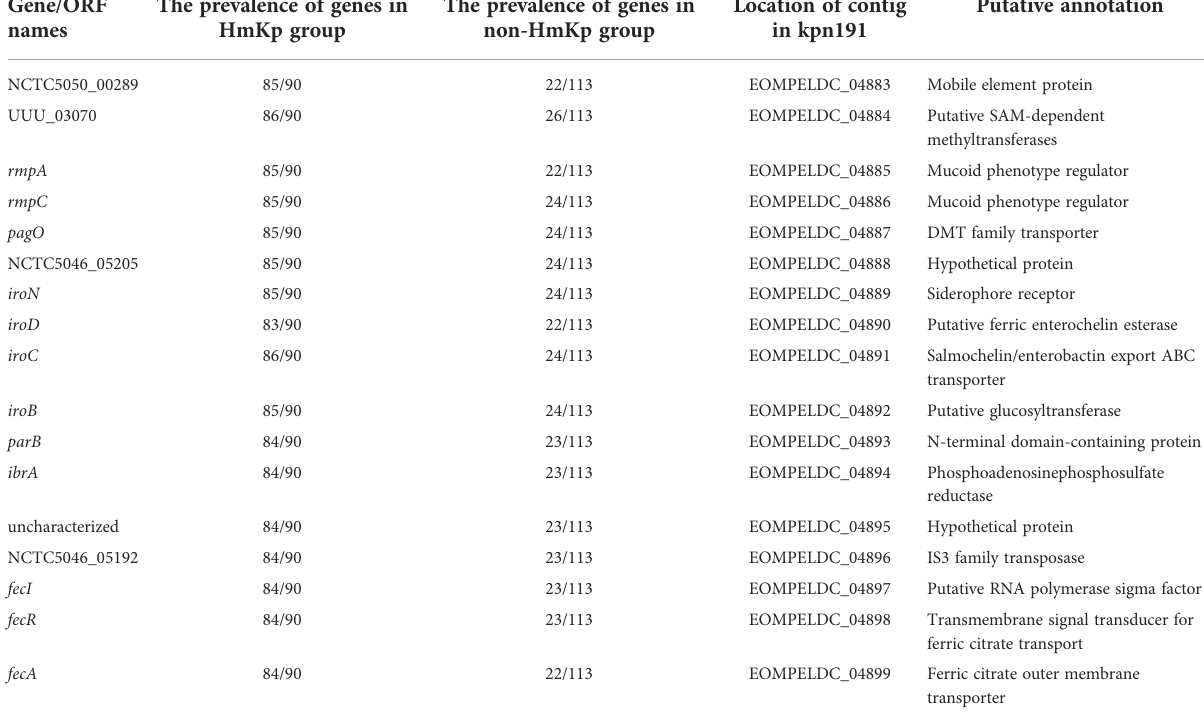
TABLE 3 Identi fi cation of 17 genes associated with